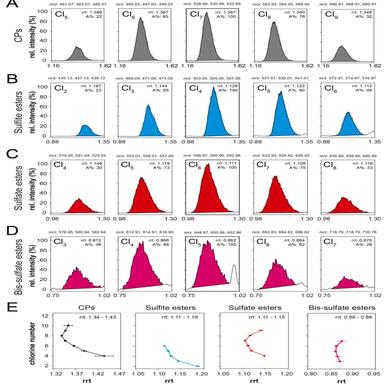
LC-QToF-MS data of CPs and side-products. Extracted ion chromatograms (EIC) of three chloride-adduct ions - of different CP-homologues (A) and sulfur- and oxygen-containing side-products (B,C,D) are plotted. These compounds were found in the crude synthesis product and were partially separated on a C18 reverse-phase column. Retention times (rrt) in relation to the one of the internal standard (γ-HBCD) are indicated together with the abundance (area%) in relation to the most prominent homologue (bold frame).